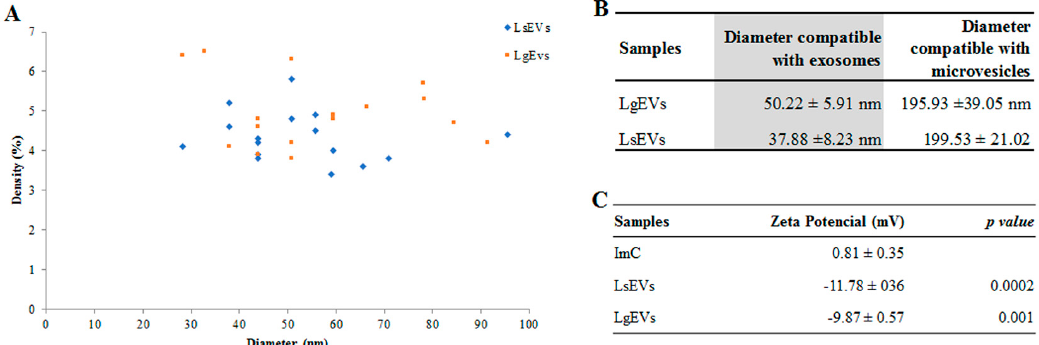
Figure 3. Diameter, density, and zeta potential of L. guyanensis and L. shawi EVs. The density and diameter of EVs shed by L. shawi (blue) and L. guyanensis (orange) are represented in a scatter plot ( A ). The mean and the standard deviation of six independent EV isolations and three readings per sample are indicated in Tables ( B , C ). Size of L. shawi and L. guyanensis EVs ( B ) and the zeta potential ( C ) were analyzed by ZetaSizer. ImC was applied as a control of the EV extraction method. Parametric Student’s t -test ( p ≤ 0.05) was used to compare the zeta potential of EVs and ImC.